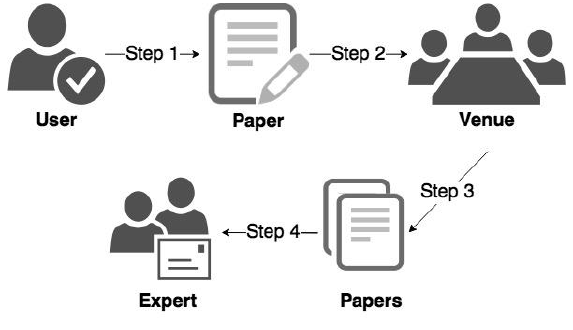
Figure 2. The proposed model overview.